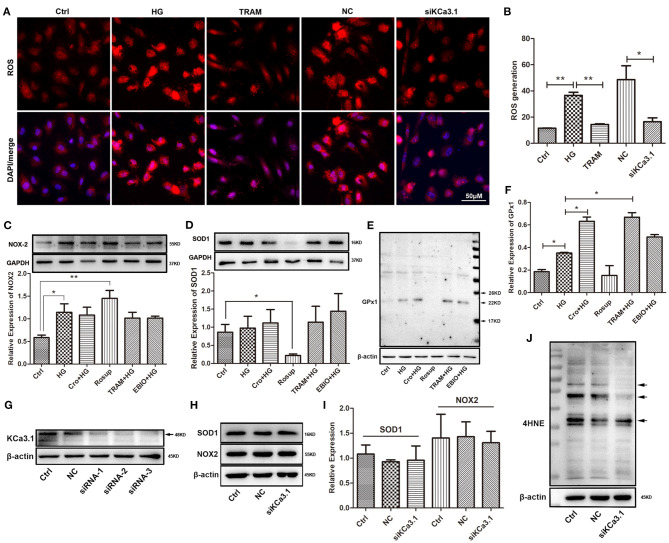
Effect of KCa3.1 on ROS production, SOD1, NOX2, GPx1, and 4HNE in HG-cultured endothelial cells. (A,B) Immunofluorescence staining identified that both blockade and knockdown of KCa3.1 significantly reduced the overproduction of ROS compared to the HG and negative control groups. (C,D) For KCa3.1, the blockade by TRAM-34 (10 μmol/L) and activation by 1-EBIO (10 μmol/L) had no alteration on NOX2 and SOD1 expressions. Moreover, Rosup enhanced NOX2 expression and reduced SOD1 expression, respectively. (E,F) GPx1 expression was slightly enhanced by HG compared to the control group, and the blockade of KCa3.1 dramatically increased GPx1 expression compared with HG. Rosup prominently suppressed GPx1 expression compared to the control group. (G) Western blotting showed that KCa3.1 was knocked down by three siRNAs of KCa3.1 (siRNA-1,−2, and−3). (H–J) The silencing of KCa3.1 could not alter the NOX2 and SOD1 expression, but it suppressed the 4HNE production (arrow). Ctrl, control (mannitol 33 mmol/L); HG, high glucose; Cro, crocin; TRAM, TRAM-34 {1-[(2-chlorophenyl)diphenylmethyl]-1H-pyrazole}; EBIO, 1- EBIO; NC, negative control; siKCa3.1, siRNA of KCa3.1; SOD1, superoxide dismutase 1; NOX2, NADPH oxidase 2; GPx1, glutathione peroxidase 1; 4HNE, 4-hydroxynonenal. Results are presented as means ± SEM of at least three independent experiments. *p < 0.05, **p < 0.01. One-way ANOVA followed by Tukey's multiple comparisons test.